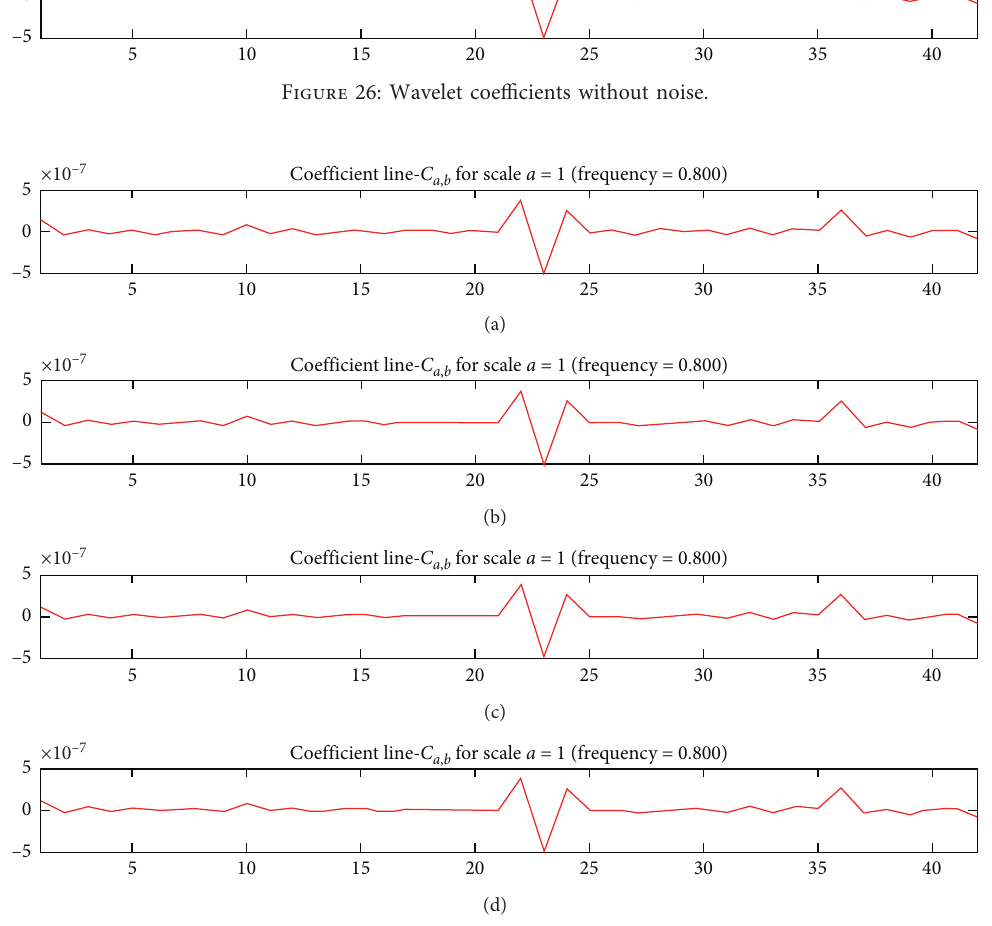
Figure 27: Wavelet coefficients with and without noise. (a) Wavelet coefficient with SNR 2dB. (b) Wavelet coefficient with SNR 10dB. (c) Denoising of the wavelet coefficient with SNR 2dB. (d) Denoising of the wavelet coefficient with SNR 10dB.